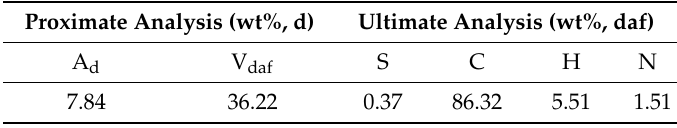
Table 2. Ultimate and proximate analysis of coal samples used in the experiment.